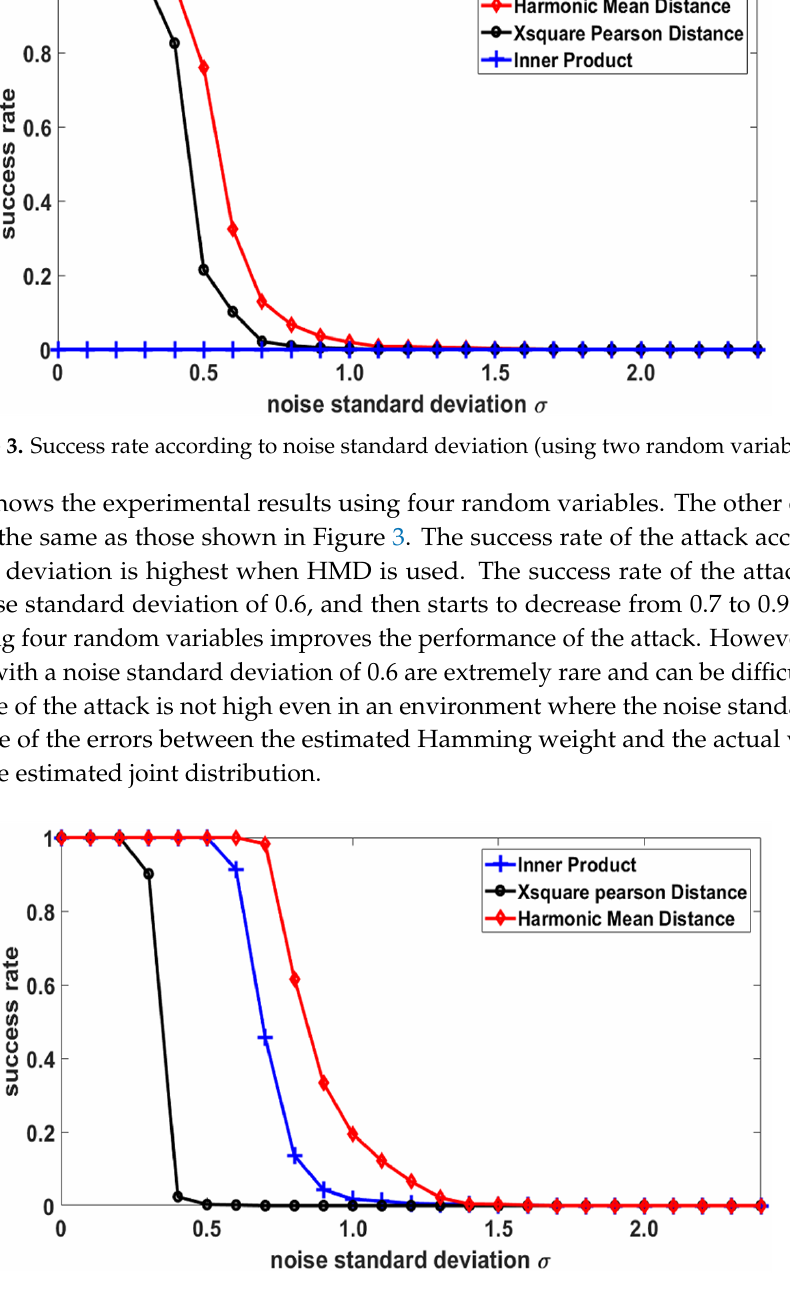
Figure 4. Success rate according to noise standard deviation (using 4 random